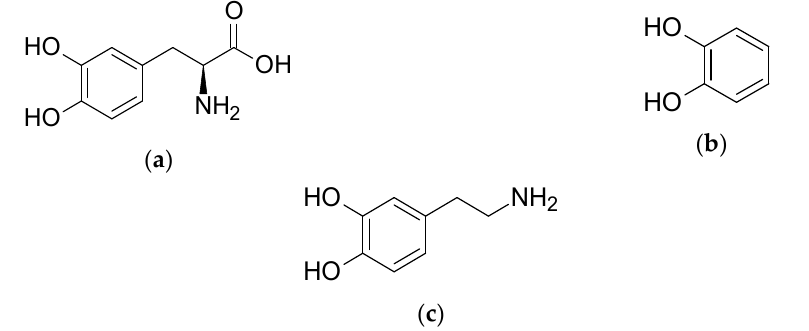
Figure 3. Schematic representation of the mussel byssus tethering system. P, D and NG refer to the different prepolymerised collagen (preCol) variants and their gradient distribution along the thread (see reference [38]). Reproduced with permission from reference [38]. Copyright (2007) The Company of Biologists.